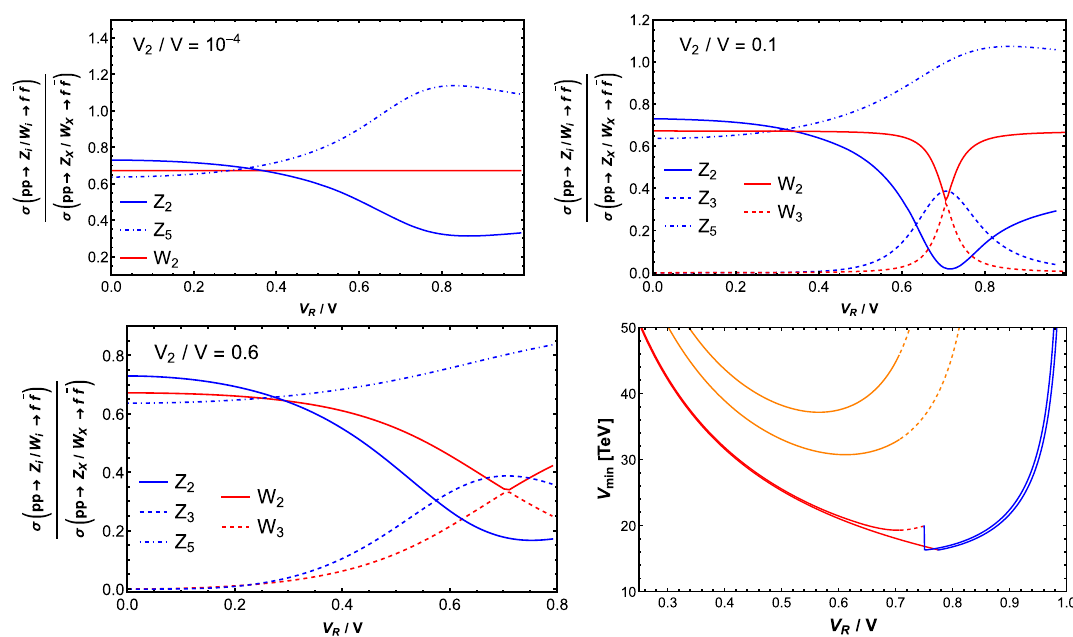
Fig. 2 Top-left, top-right and bottom-left panels show the ratio of the resonance production cross sections of W i ( Z i ) and W X ( Z X ) bosons, whichareusedinLHCstudies.Weplottheratioasfunctionof V R / V for fixed g L = 0 . 63, g R = 0 . 71 g L and V 2 / V . For V 2 / V = 10 − 4 the reso- nanceproductioncrosssectionof W 3 and Z 3 ishighlysuppressed.Inthe bottom-rightpanel,weplotthelowerboundon V asafunctionof V R / V .